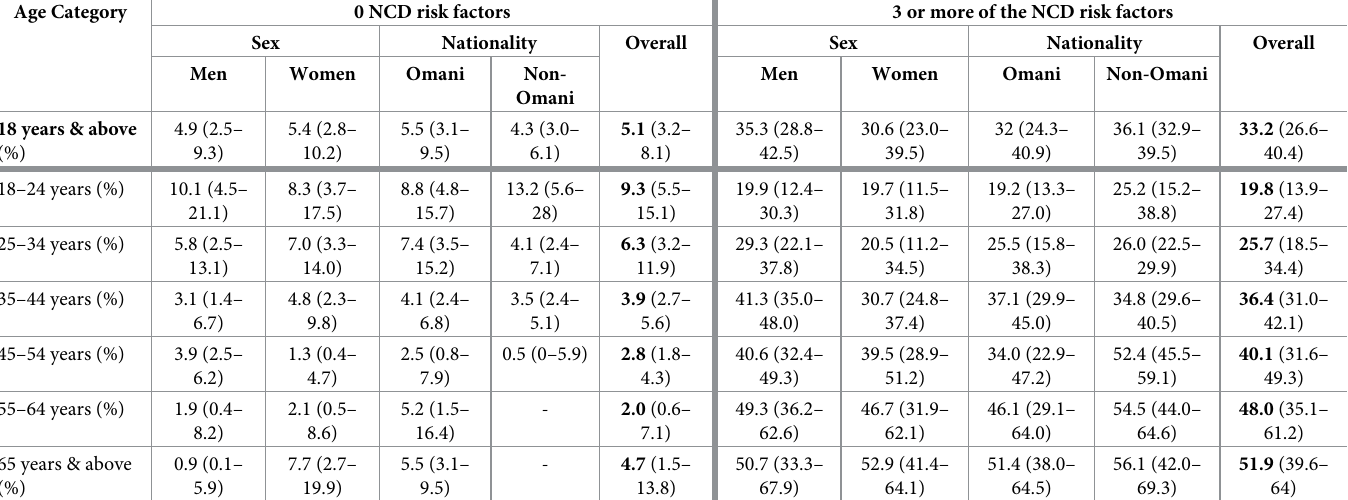
Table 5. Summary of combined risk factors by sex, nationality, and age groups. Age